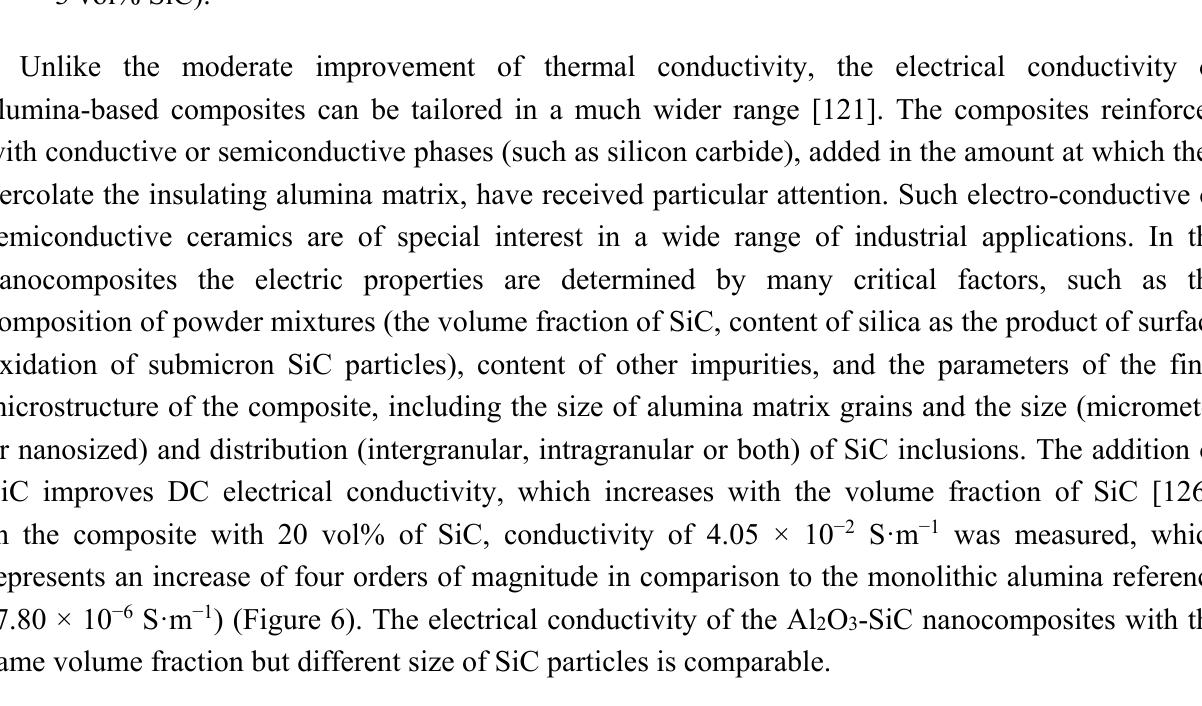
Figure 5. Temperature dependence of thermal conductivity of Al 2 O 3 -SiC (AS) nanocomposites with various volume fractions of SiC. Comparison to monolithic alumina reference [126]. The number in the sample denomination represents the volume fraction of SiC in the material ( i.e. , AS3c represents the Al 2 O 3 -SiC nanocomposite containing 3 vol%